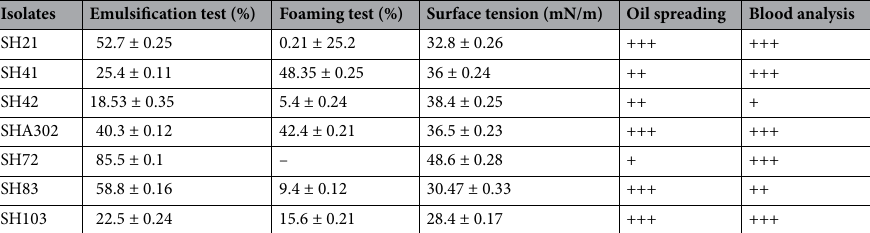
Table 1. Characteristics of produced surfactants by seven bacterial isolates. Oil Spreading Test (cm): ( +) mean of the halo diameter between 0.5 and 0.9, (++) between 1 and 1.5, (+++) between 1.5 and 2.1, (++++) between 2.1 and 3. Blood hemolysis test (cm): (–) without hemolysis, (+) incomplete hemolysis, (++) complete hemolysis with diameter < 1, (+++) complete hemolysis with diameter between 1 and 3, (++++) complete hemolysis with diameter > 3. The initial ST of the culture medium was equal to 70.5